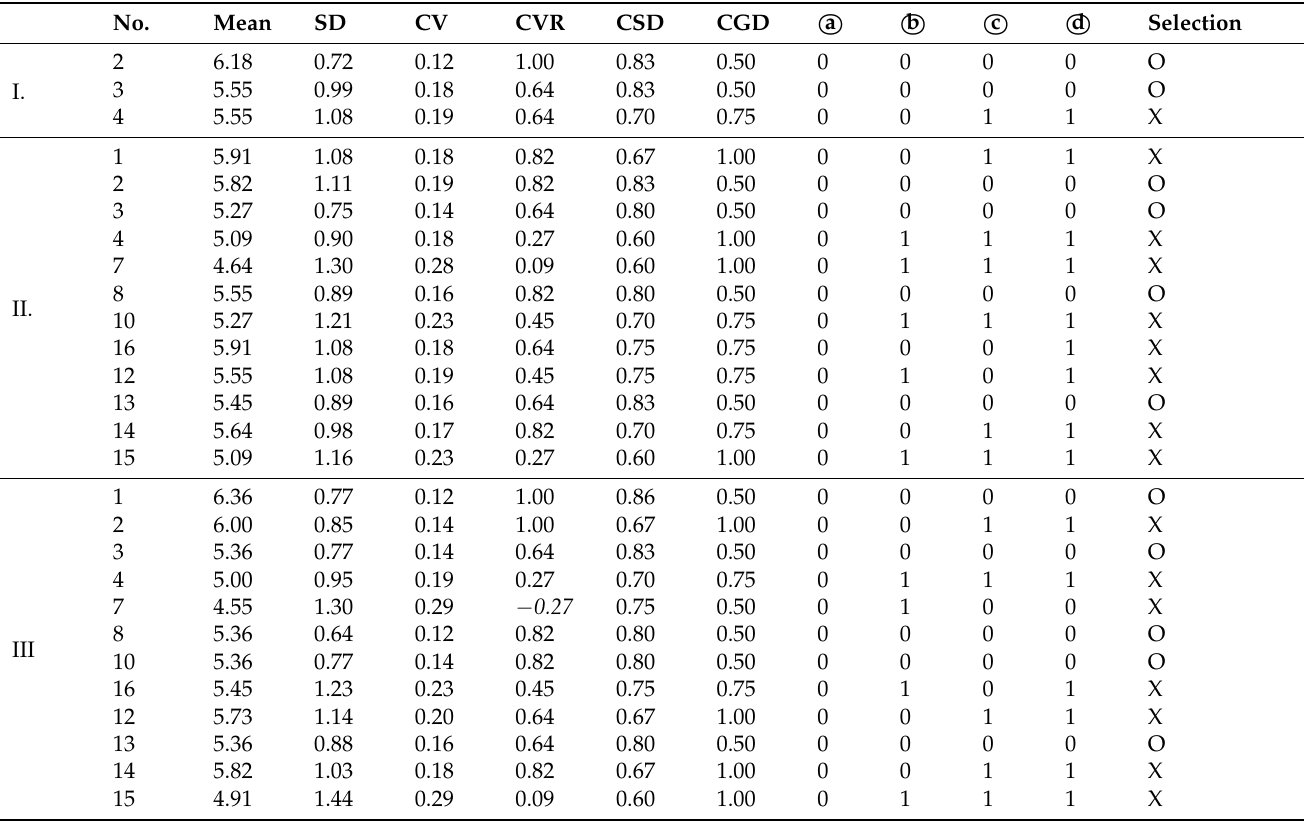
Table 8. Secondary conformity assessment results.